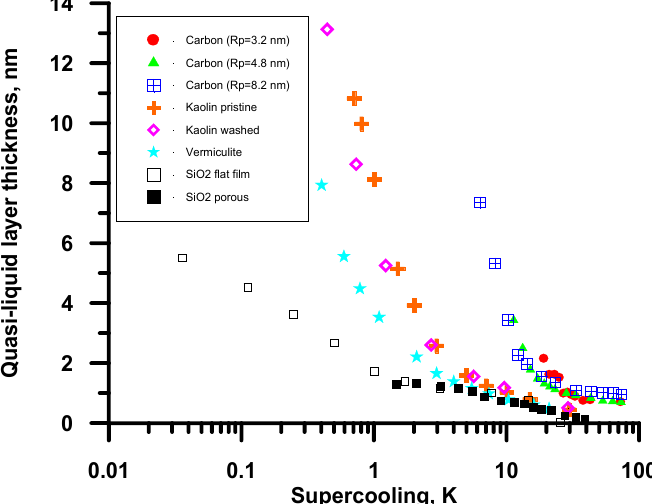
Figure 3. Thicknesses of a quasi ‐ liquid layer on the ice surface in contact with different substrates as a function of supercooling with respect to bulk freezing temperature. Experimental data for porous carbon with different pore radii [58] and for kaolin (pristine and washed) and vermiculite clays [57] were estimated from high energy X ‐ ray diffraction; for flat amorphous SiO 2 film on Si block by the X ‐ ray reflectivity measurements [59]; and for porous SiO 2 particles imbibed with D 2 O by NMR studies [60].